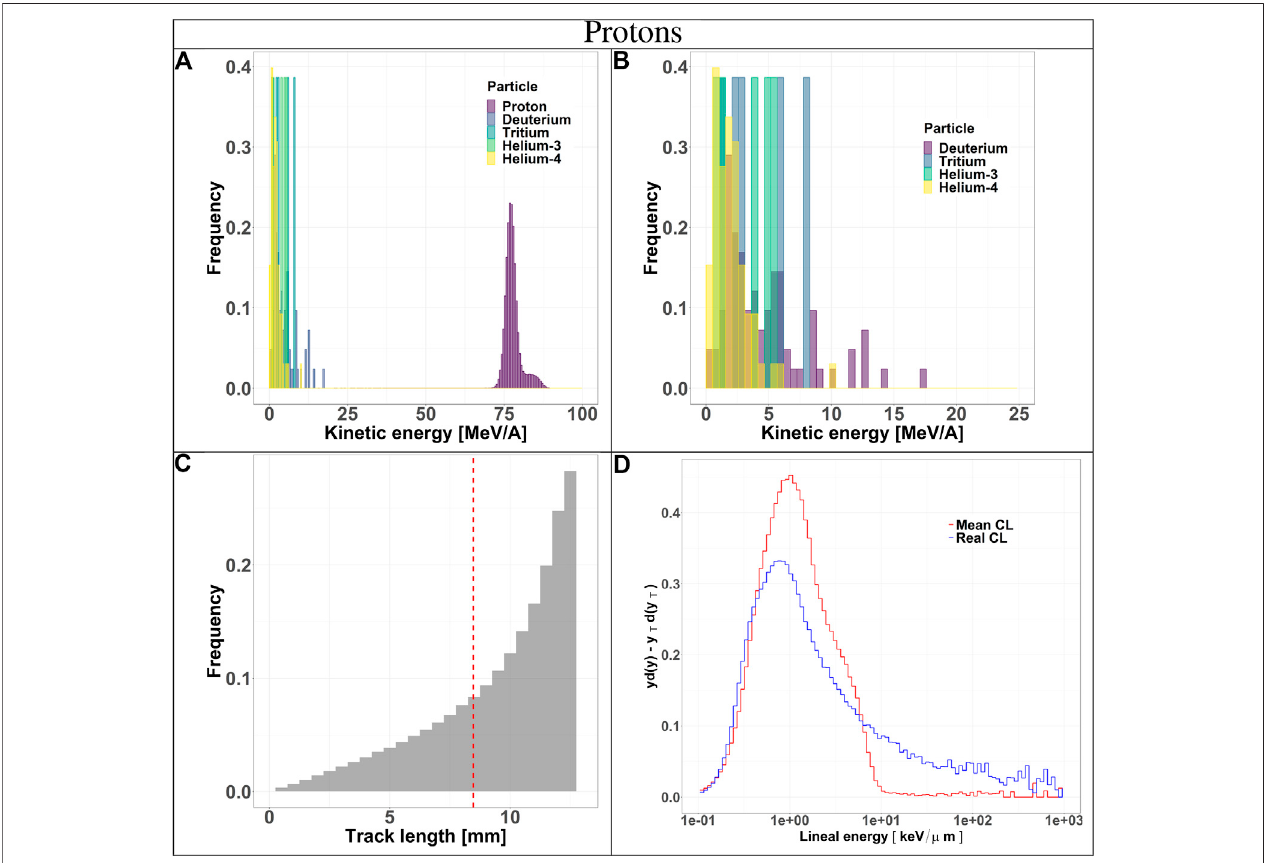
FIGURE 3 | Characterization of the radiation fi eld generated by 150 MeV protons after traversing 10.74 cm of water and seen by the TEPC. Panels (A) and (B) : kinetic energy spectra of the most abundant components of the radiation fi eld including and excluding the primary ions. Panel (C) : track length distribution of all the particles detected by the TEPC. The mean chord length at 8.47 mm is marked with a red dotted line. Panel (D) : microdosimetric yd(y) spectra obtained with the mean chord length approximation (red line) and microdosimetric yd T ( y T ) spectra obtained using the real chord length values (blue line).